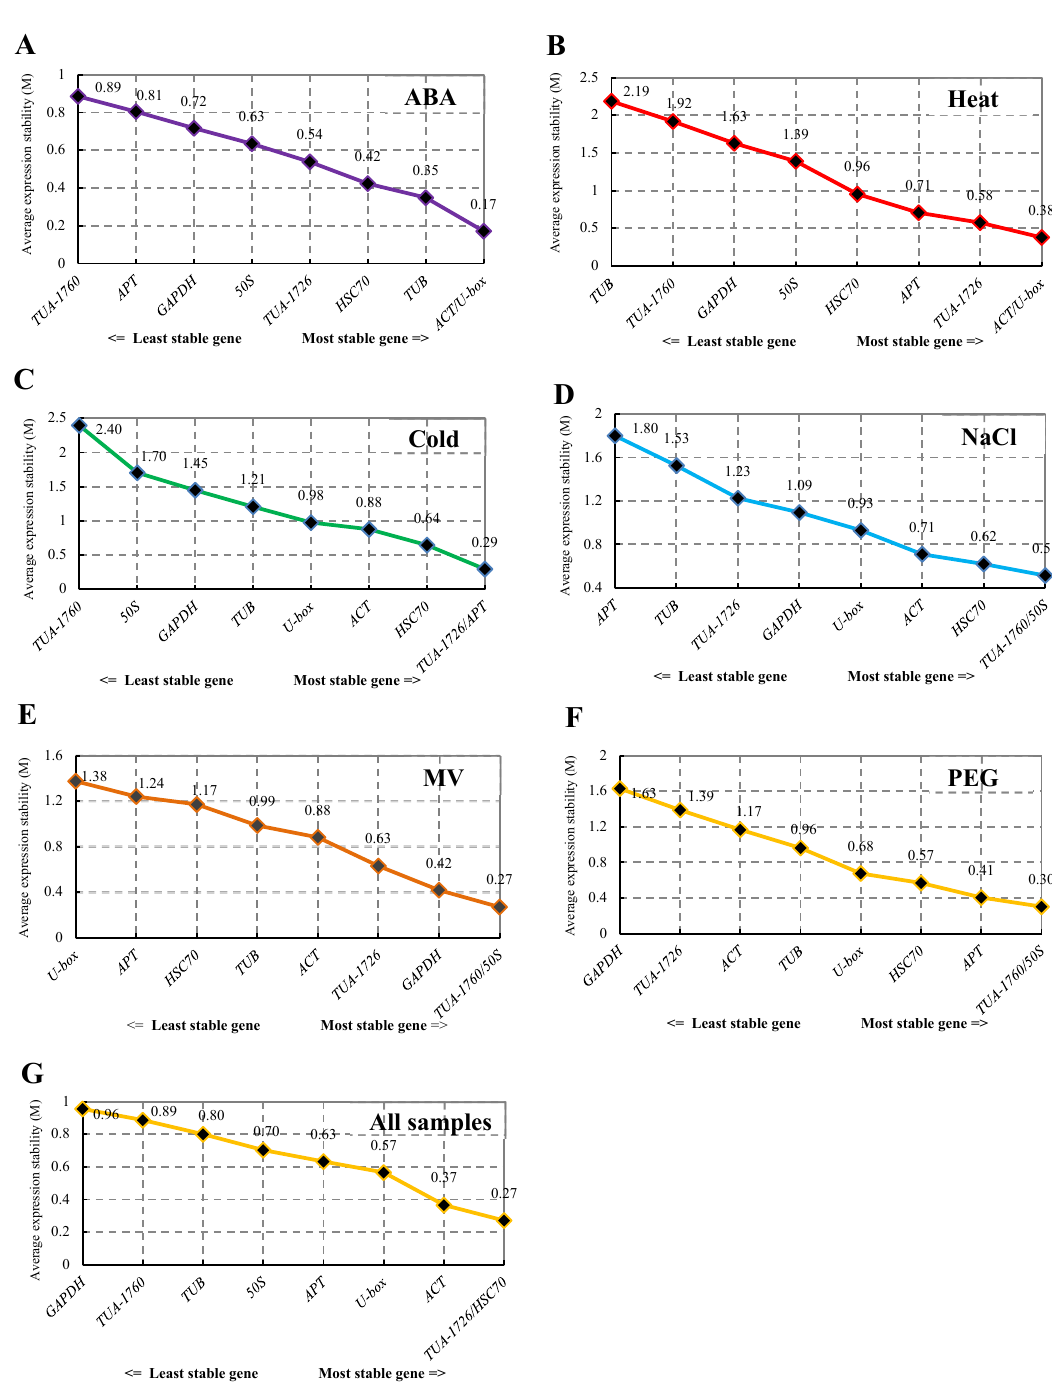
Figure 3. Expression stability values of 9 internal reference genes analyzed by geNorm software. ( A ) Internal reference genes in the ABA treatment group. ( B ) Internal reference genes of heat-treated samples. ( C ) Stability ranking of internal reference genes in all samples treated with cold. ( D ) Internal reference genes from NaCl-treated samples. ( E ) Reference genes derived from MV. ( F ) PEG-treated samples representing drought treatment. ( G ) All samples used in this study.